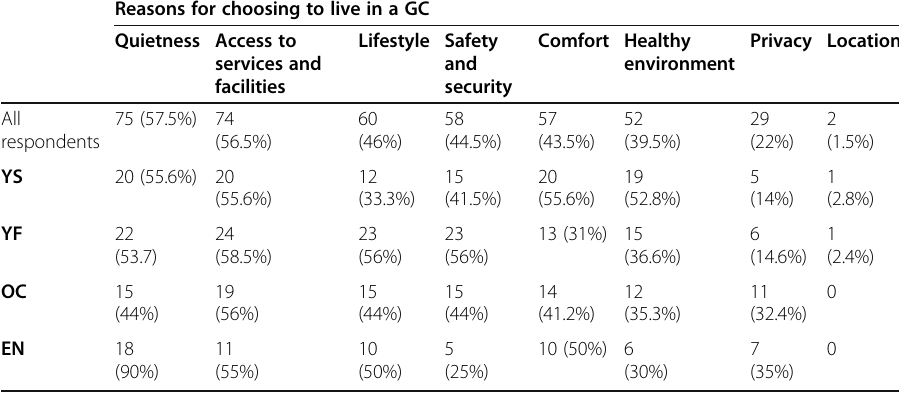
Table 3 Main reasons for choosing to live in a GC Reasons for choosing to live in a GC Quietness Access to Lifestyle Safety Comfort Healthy Privacy Location services and and environment facilities security